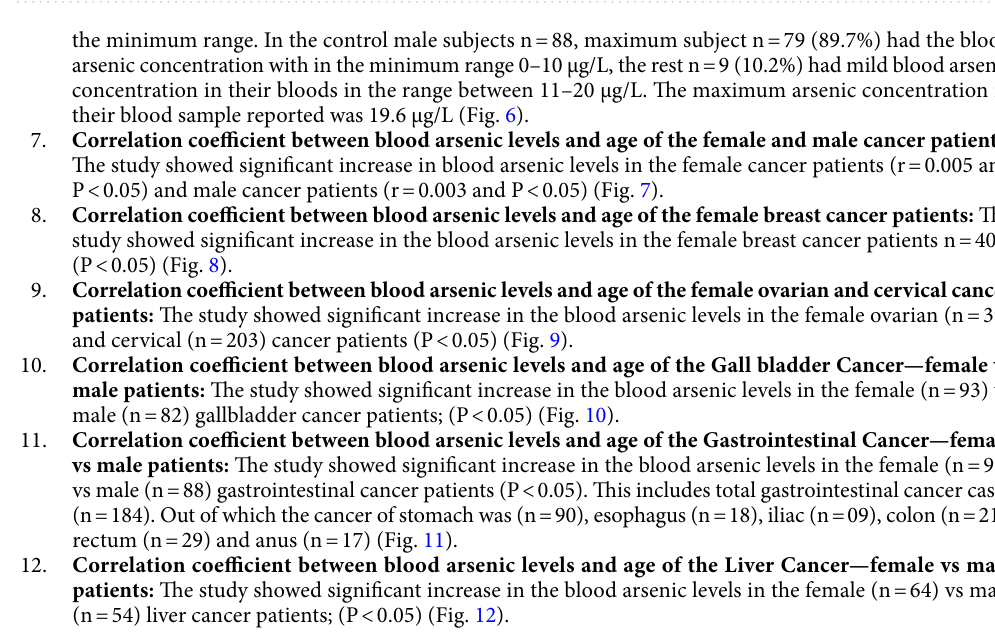
Figure 7. The correlation coefficient between blood arsenic levels and age of the female (n = 1213) (r = 0.005 and P < 0.05) and male (n = 787) cancer patients (in years) (r = 0.003 and P <